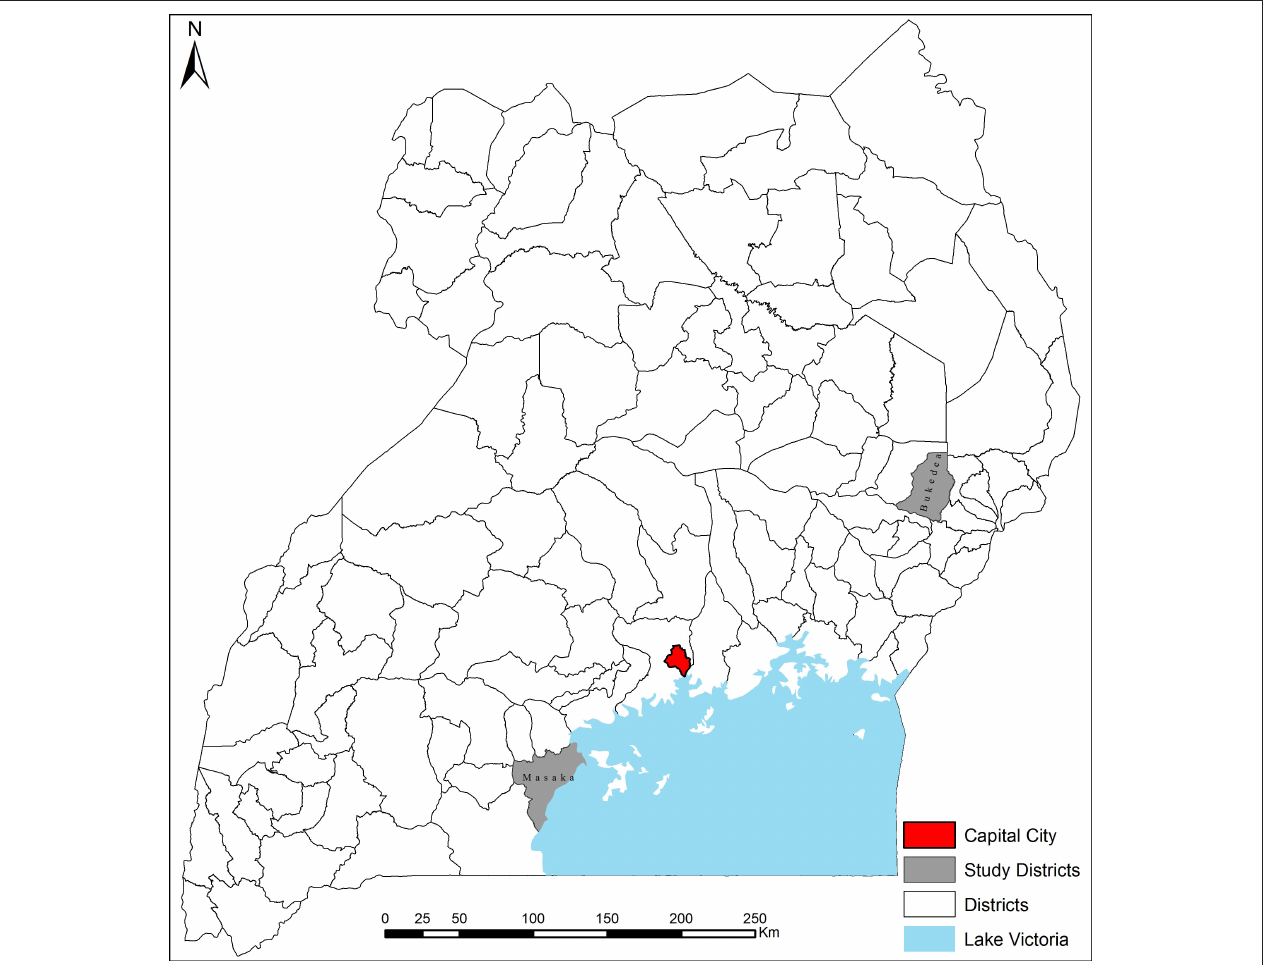
FIGURE 3 | Location of the study